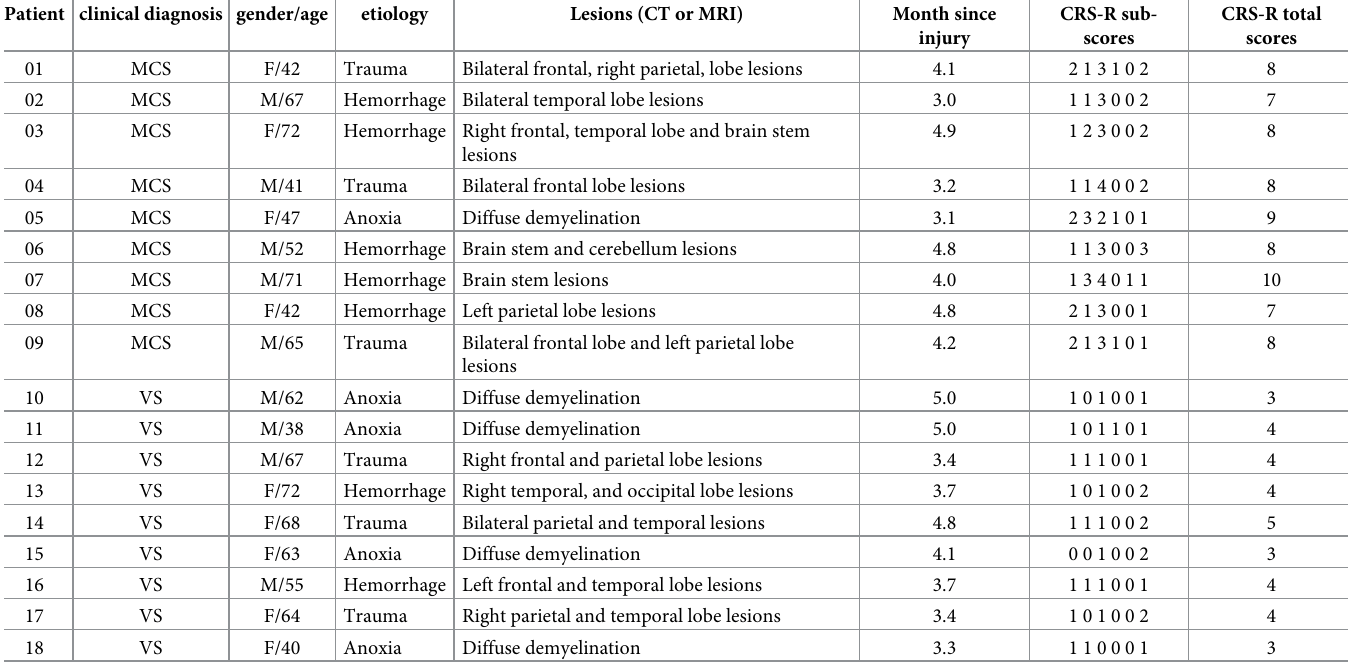
Table 1. Clinical and demographic details of DOC patients. Patient clinical diagnosis